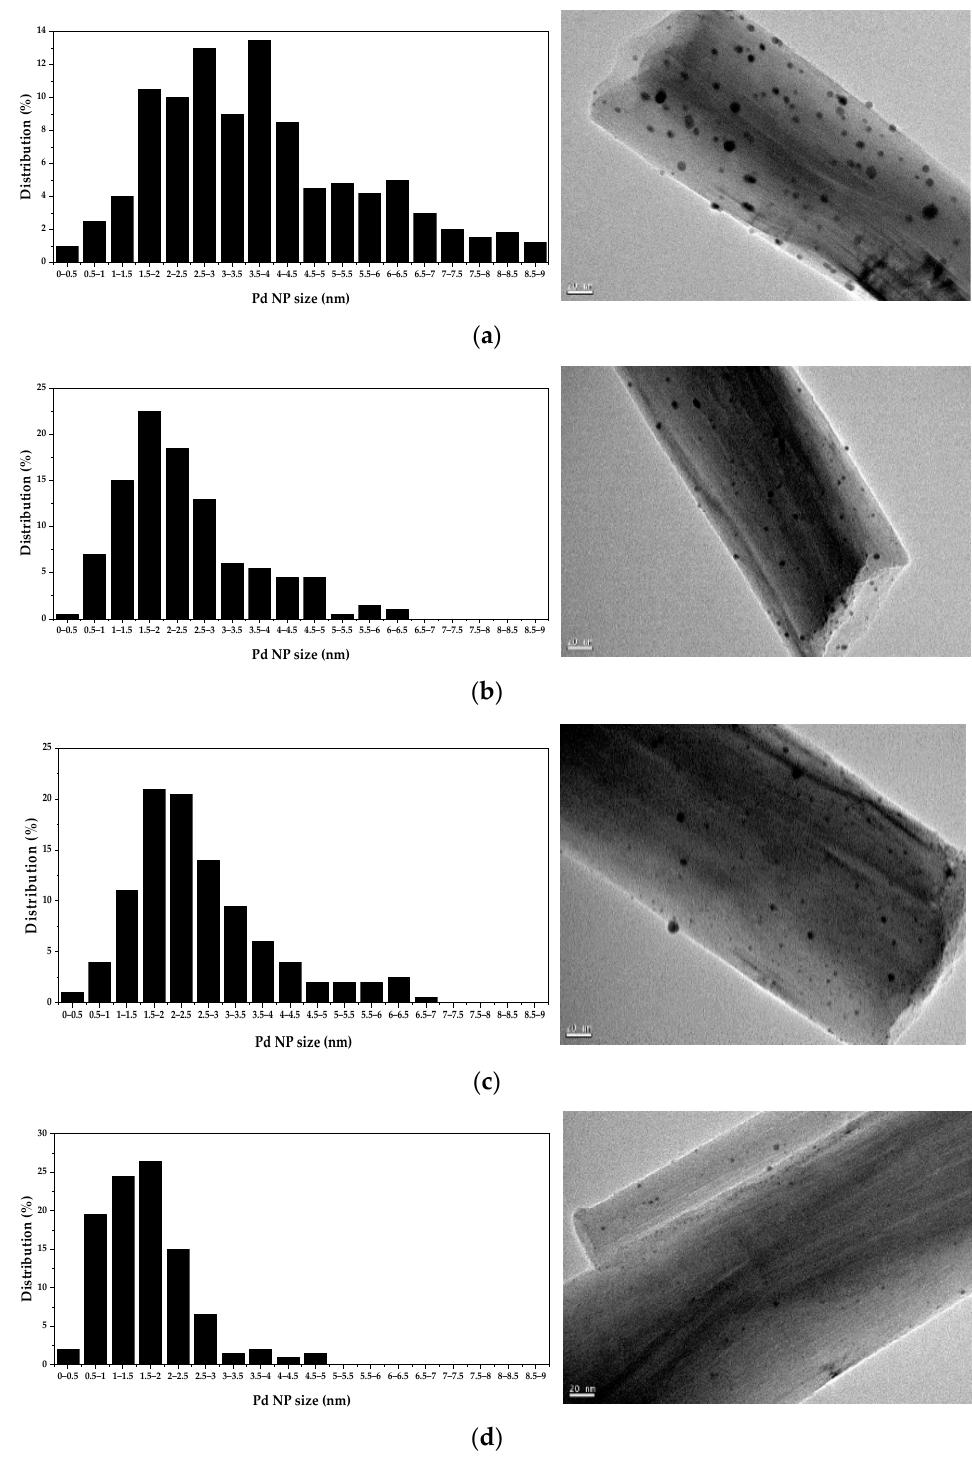
Figure 1. Distribution of Pd NP size on different catalysts (( a ) Pd/CNF; ( b ) Pd/CNF-Cl; ( c ) Pd/CNF-N; ( d )